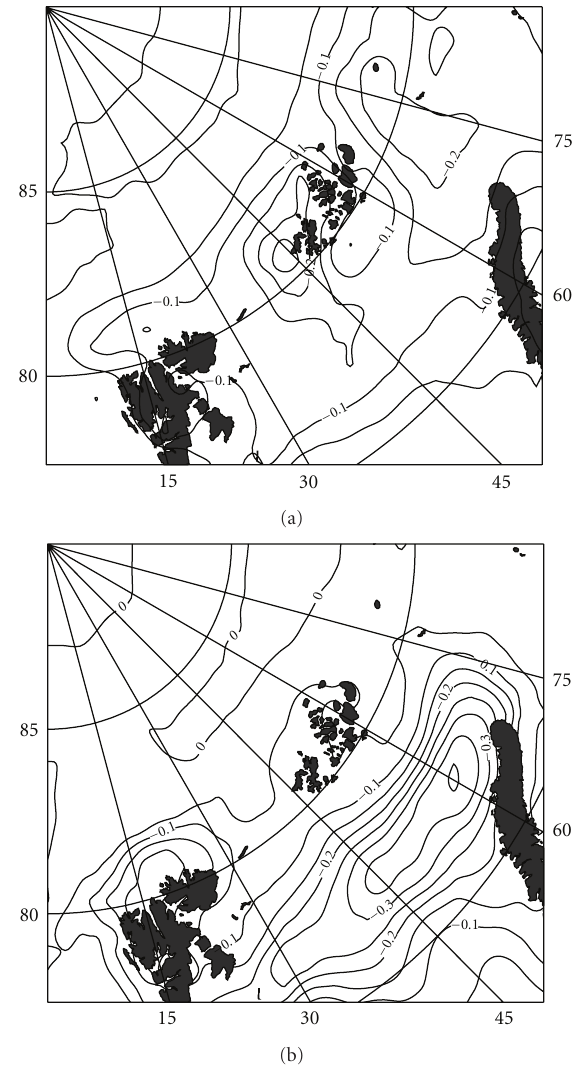
Figure 5: Di ff erence between the average ice concentrations in the WNB in 1999–2011 versus in 1979–1995 in summer (a) and in winter